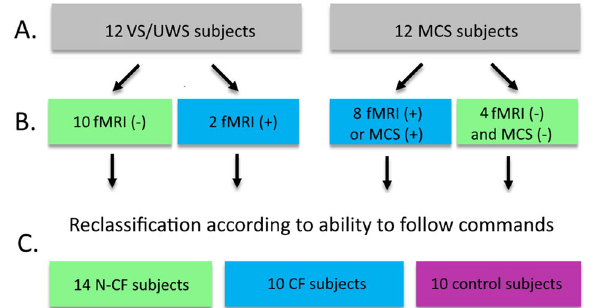
Figure 1. Classification of subjects. ( A ) Behavioural classification based on consecutive applications of the CRS-R. ( B ) The ability to follow commands is determined based on the evidence coming from fMRI imagery task and/or from CRS-R. ( C ) Reclassification of subjects according to their ability to follow commands.